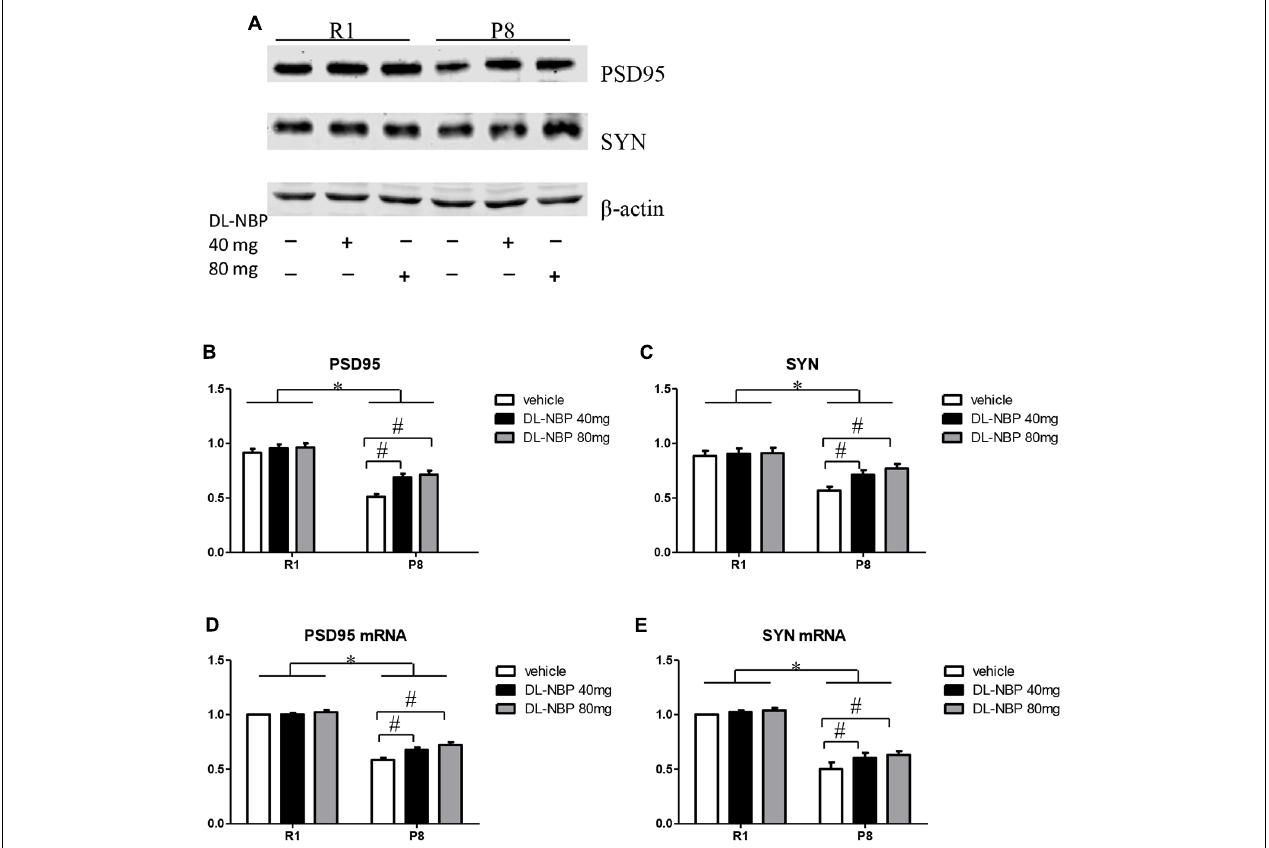
FIGURE 4 | Effects of DL-3- n -butylphthalide (DL-NBP) management on structural synaptic plasticity in the hippocampus of SAMP8 mice. (A–C) Representative western blot images of synaptophysin (SYN) and postsynaptic density protein 95 (PSD95). (D,E) SYN and PSD95 mRNA levels in the SAMP8 hippocampus. Values were normalized to β -actin and the mRNAs were expressed as a percentage of the SAMR1 vehicle-treated samples. Data are presented as the mean ± standard error of the mean (SEM). ∗ p < 0.01 versus R1 group, # p < 0.01 versus P8 vehicle group. R1, SAMR1 mice; P8, SAMP8 mice ( n =